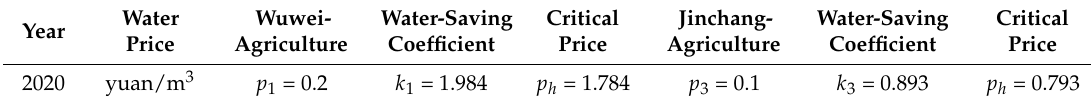
Table 12. Relationship between critical water transaction price and water-saving cost coefficient in